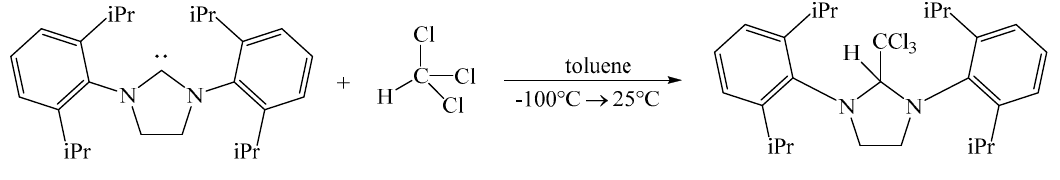
Scheme 1. Reaction scheme for the synthesis of SIPr(H)CCl 3 .